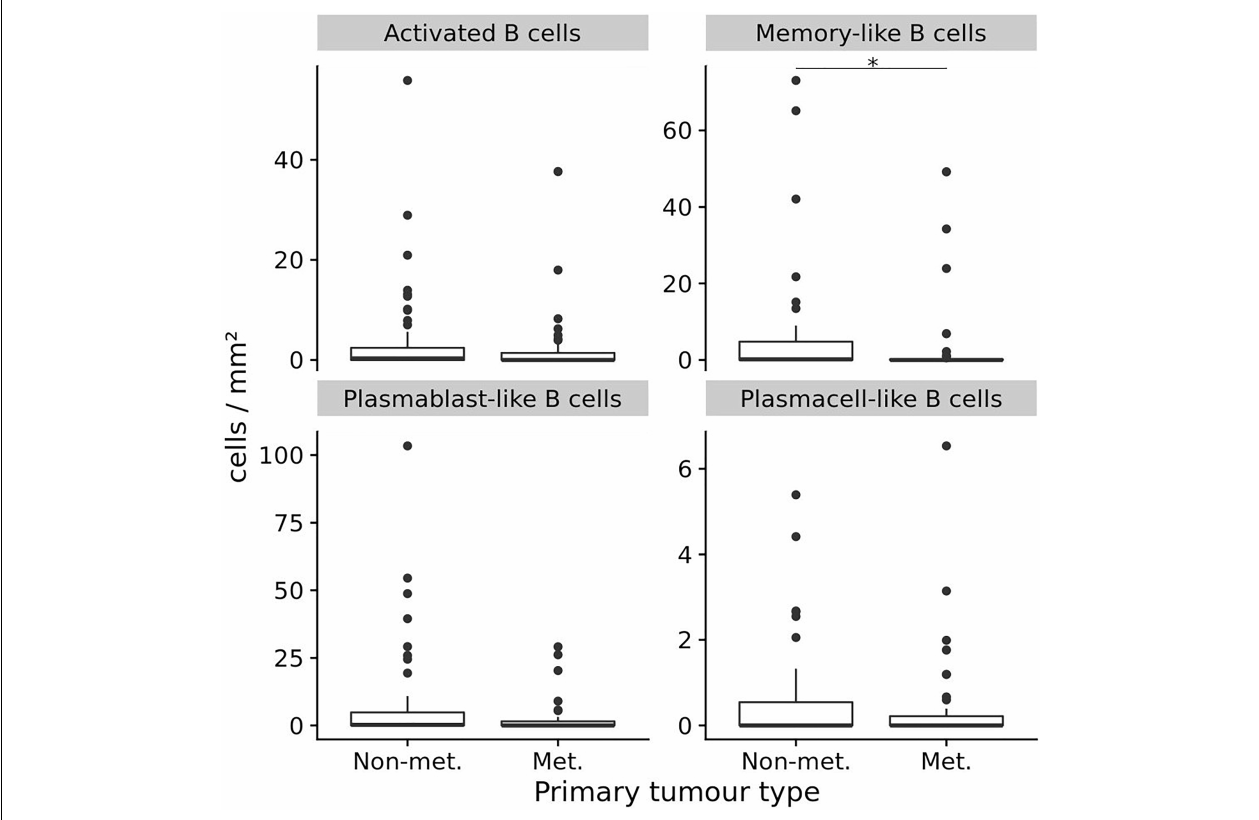
FIGURE 2 | The frequencies (cells/mm 2 ) of four different TAB and ASC subpopulations in primary human melanomas and their association with metastasis. Box plots comparing primary tumors that did not metastasize (Non-met.) within a mean follow-up of 84 months vs. those that metastasized (Met.) with a mean follow-up of 54 months. FDRs are 0.02 for memory-like TAB and 0.17 for plasmablast-like ASC. In boxplots lower and upper hinges correspond to first and third quartiles and center lines to medians. Upper whiskers extend to the largest value within 1.5 times the interquartile range. Outliers are shown as black circles. ∗ p ≤